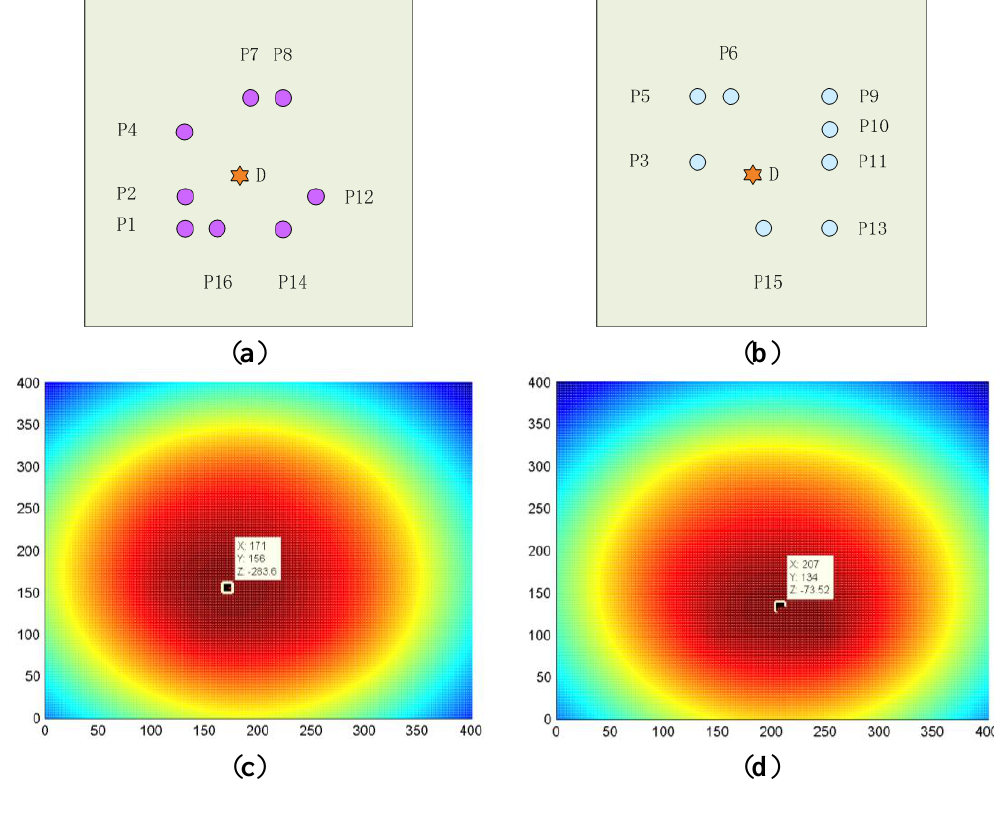
Figure 12. The tomography of the transducer array sparse optimizing results. ( a ) The top 8 transducers among the 16 all; ( b ) The relatively bad 8 transducers among the 16 all; ( c ) The top 8 transducers tomography evaluated damage location: (171,156); ( d ) The relatively bad 8 transducers tomography evaluated damage location: (207,134); (unit: